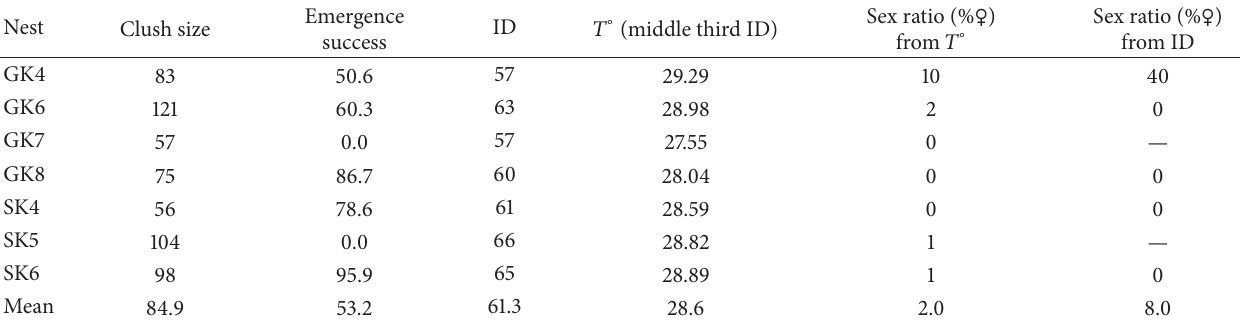
Table 4: Information on studied nests with estimated sex ratio (% C ).